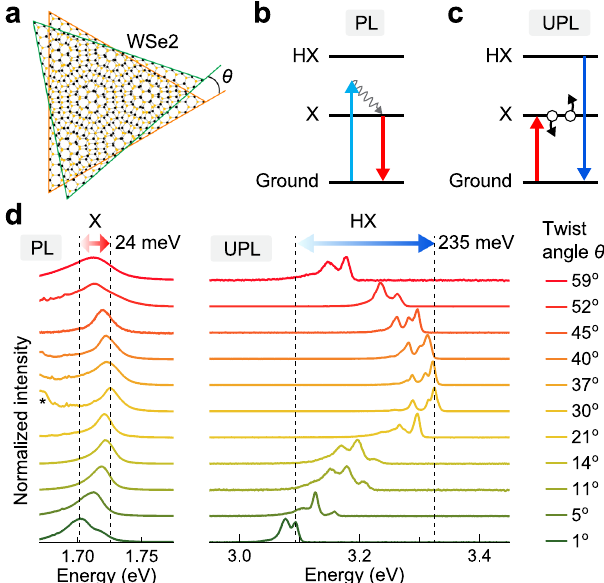
Fig. 1 Twist-angle dependence of the A-exciton (X) and the high-lying exciton (HX) photoluminescence (PL) at 5 K. a Illustration of arti fi cial twisted-bilayer WSe 2 with a stacking angle of θ . b Origin of the A-exciton PL (red arrow) under 488 nm continuous-wave excitation (blue arrow). The gray arrow indicates nonradiative relaxation. c Origin of the upconverted HX PL (UPL) (dark blue arrow) arising through an Auger-like exciton – exciton annihilation process (black circles and arrows) under resonant pumping of the A-exciton (red arrow). d Variation of the A-exciton PL (left panel) and HX UPL (right panel) with twist angle θ . The energy of X only varies within a 24meV range as marked by the double-headed red arrow and dashed lines, while the energy of HX varies over 235meV as marked by the blue arrow. The intervalley exciton is marked by an